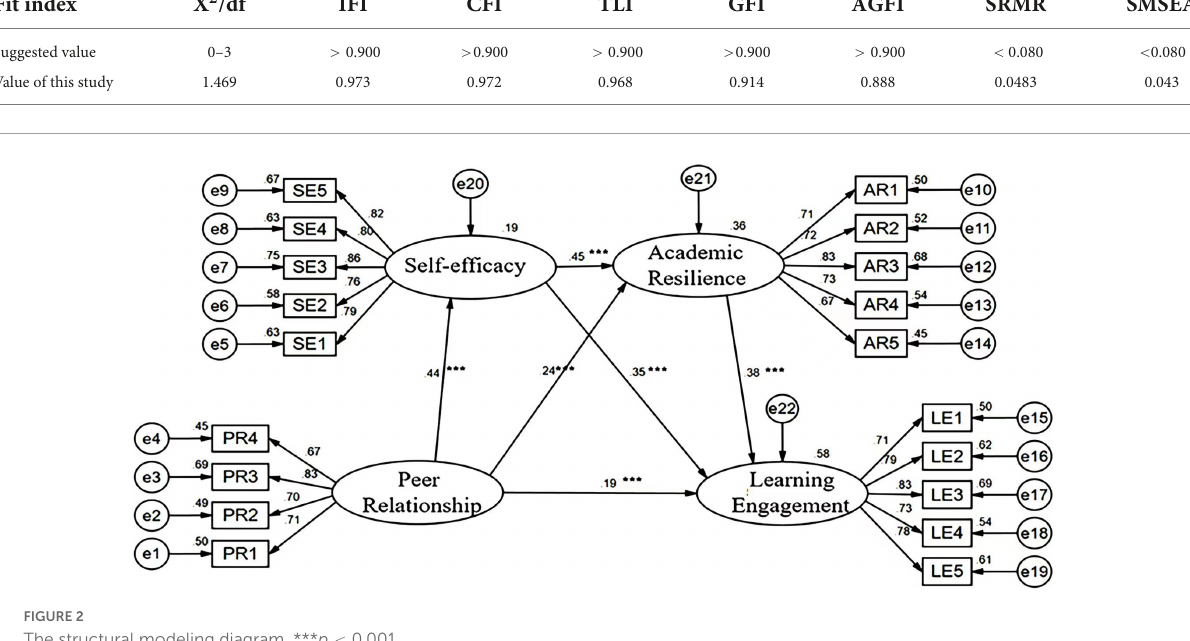
TABLE 5 Goodness of fit index of the structural model.